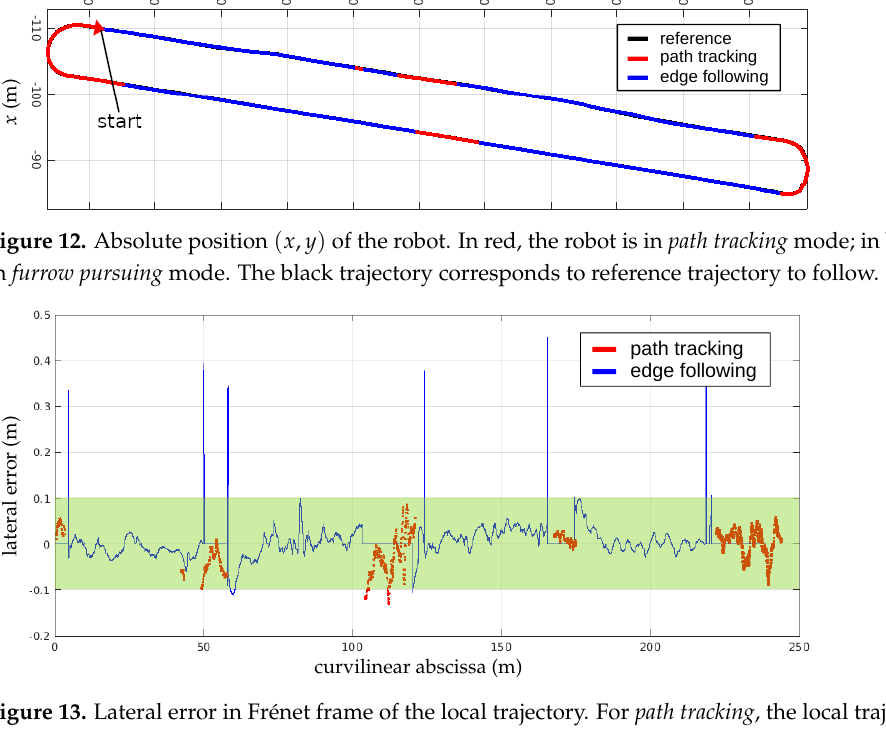
Figure 13. Lateral error in Frénet frame of the local trajectory. For path tracking , the local trajectory is the reference trajectory, and for furrow pursuing , it is built from the furrow